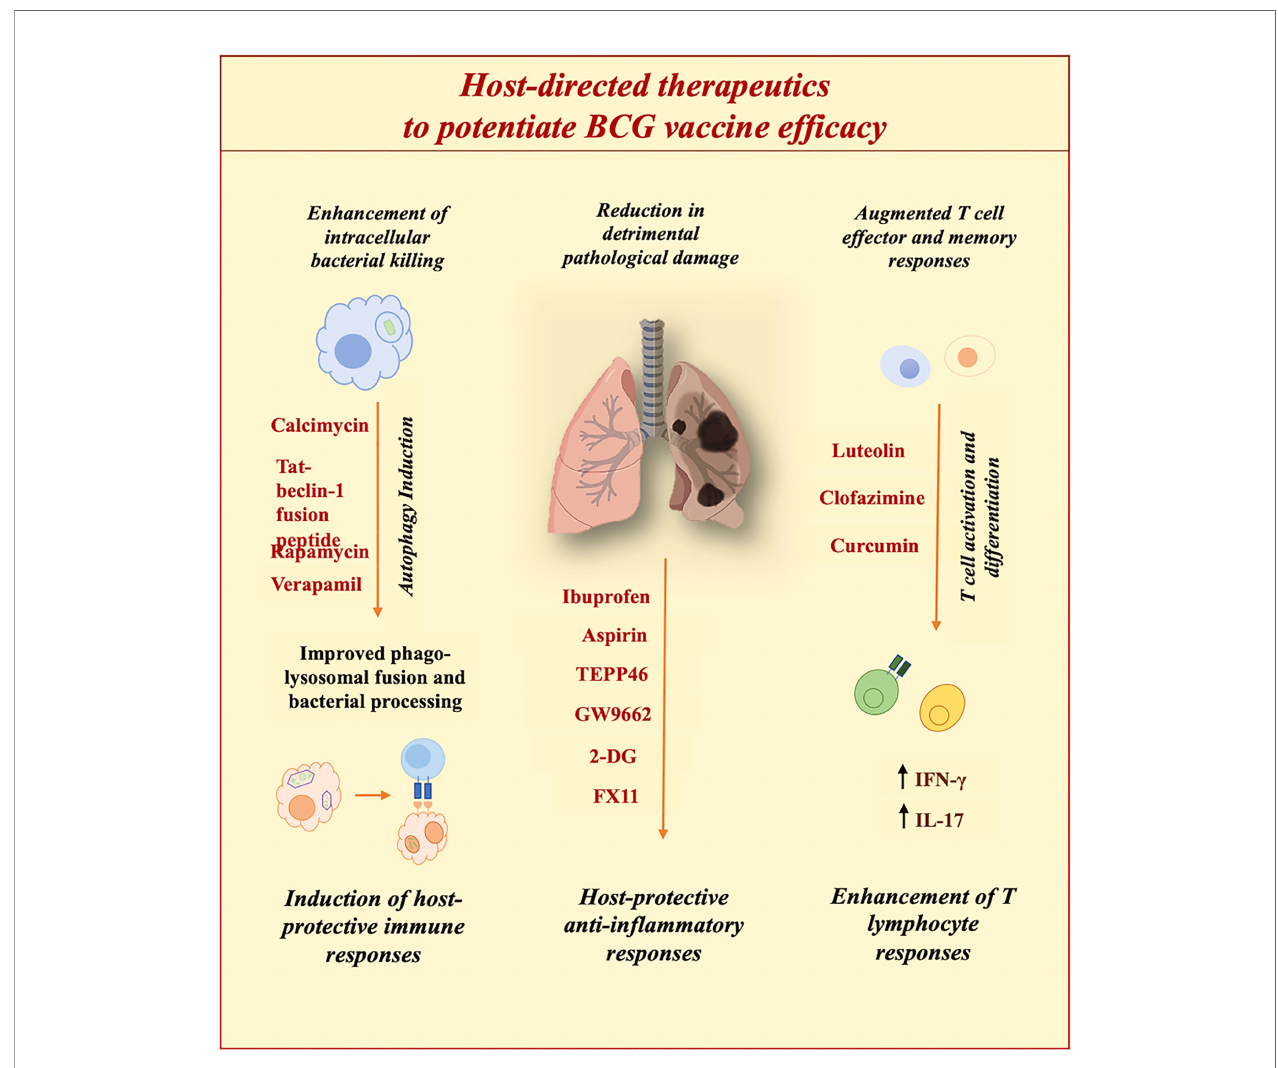
FIGURE 3 | Potential of host-directed therapies (HDTs) to improve BCG ef fi cacy. Diverse HDTs aiming at distinct pathways are under evaluation to improve clinical outcomes. HDTs restrict pathogen-induced subversion strategies to ameliorate host defenses against M.tb .